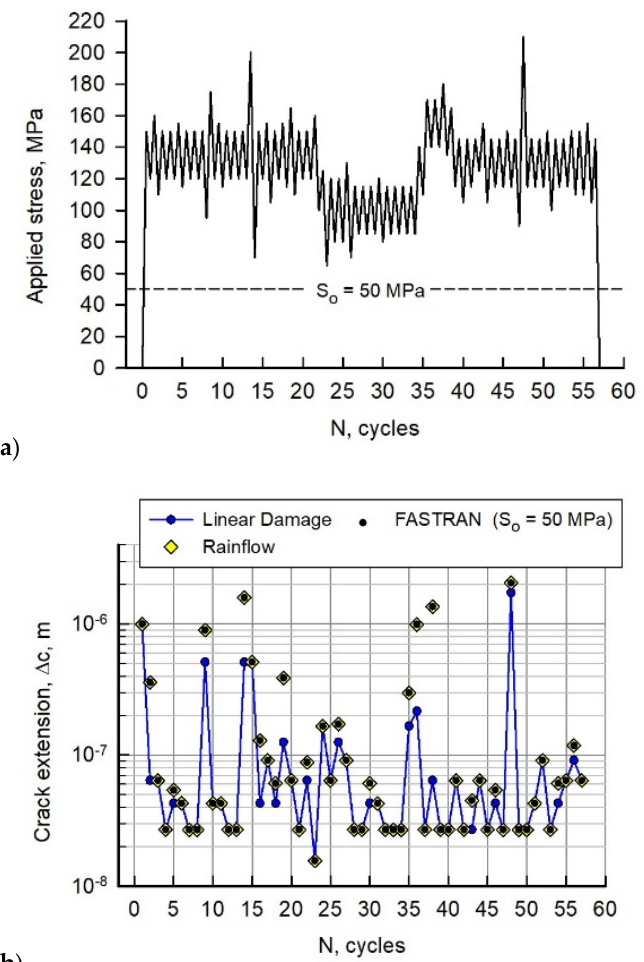
Figure 4. ( a ) Loading sequence B1. ( b ) Calculated crack extension per applied cycle for load se- quence